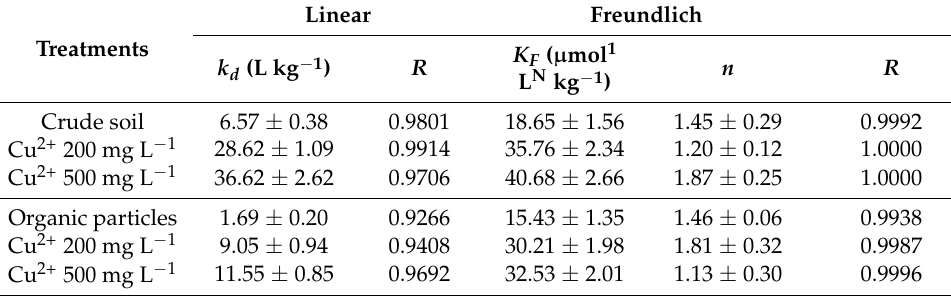
Table 5. Fitting results of the Linear and Freundlich models for adsorption curves of SDZ on soil composition (mean values ± standard